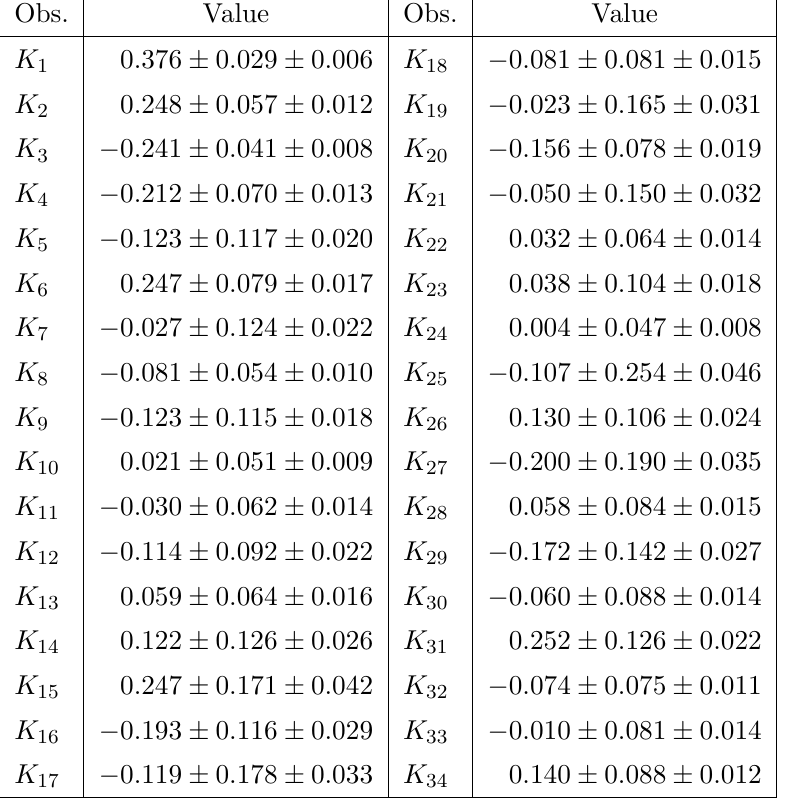
Table 3 . Measured values for the angular observables from the Run 1 data combining the results of the moments obtained from the candidates reconstructed in the long- and downstream-track p(cid:25) (cid:0) categories. The (cid:12)rst and second uncertainties are statistical and systematic, respectively.